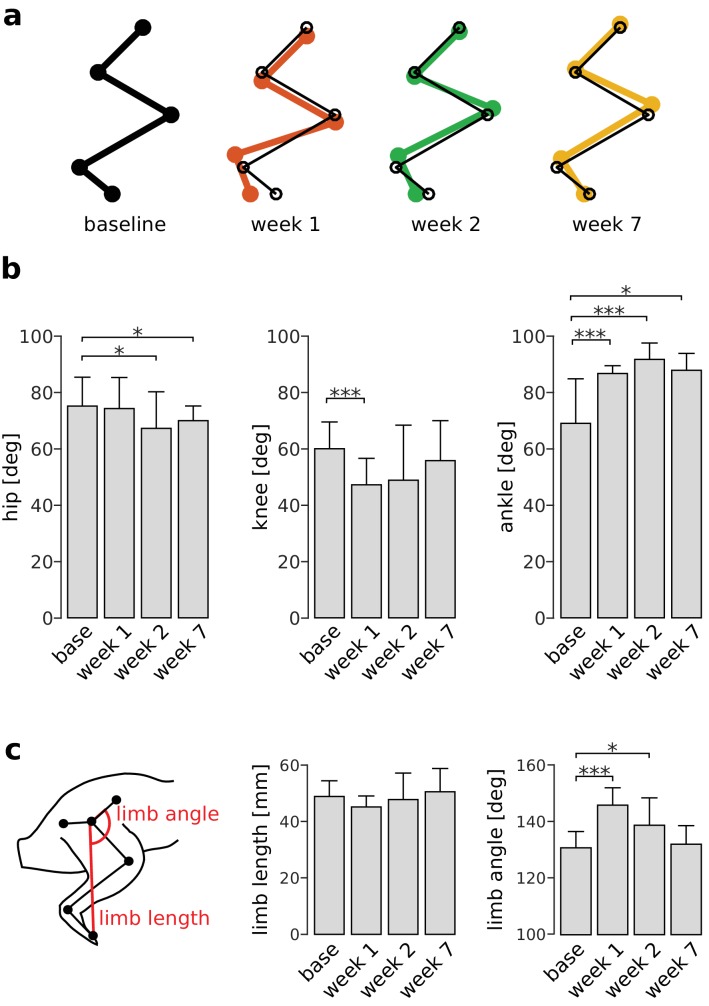
Joint configurations measured at mid-stance.Conventions are the same as in Figure 6. Panel (a) illustrates limb configurations at mid-stance at baseline (black), week 1 (red), week 2 (green), and week 7 (orange) after VL paralysis. Panel (b) shows the angles at the hip, knee, and ankle averaged across animals before and after VL paralysis (averages ± s.d. across animals). Hip: pweek1 = 1, pweek2 = 0.027, pweek7 = 0.011; N = 5, 5, 4, 5 animals for base, week 1, week 2 and week 7, and an average number of strides of Ns = 53, 42, 44, 74 strides. Knee: pweek1 <0.001, pweek2 = 0.395, pweek7 = 0.140; N = 6, 5, 5, 5 animals, and Ns = 59, 50, 41, 74 strides. Ankle: pweek1 <0.001, pweek2 =< 0.001, pweek7 = 0.038; N = 6, 4, 5, 5 animals, and Ns = 55, 49, 39, 73 strides. Panel (c) shows the global kinematic parameters limb angle and limb length averaged across animals before and after VL paralysis (averages ± s.d. across animals). Limb length: pweek1 = 0.060, pweek2 = 1, pweek7 = 1; N = 6, 4, 5, 5 animals, and Ns = 59, 51, 40, 74 strides. Limb angle: pweek1 <0.001, pweek2 = 0.015, pweek7 = 1; N = 5, 4, 4, 5 animals, and Ns = 54, 41, 42, 74 strides. *p<0.05; **p<0.01; ***p<0.001.10.7554/eLife.38215.016Figure 6—figure supplement 1—source data 1.Joint kinematics and global limb kinematics in the middle of the stance phase of locomotion.